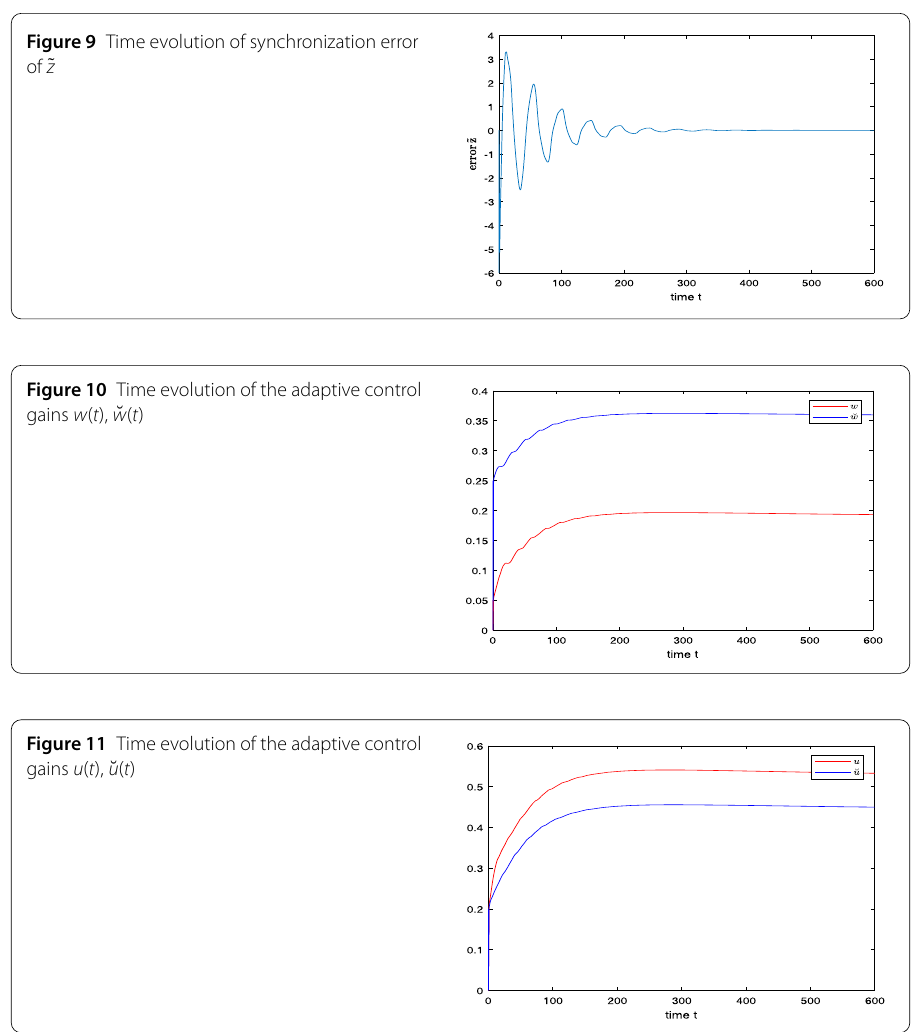
starting from initial values x ( s ) = 2, y ( s ) = 3, ˜ x ( s ) = –2, ˜ y ( s ) = –3 for s ∈ [–1,0],